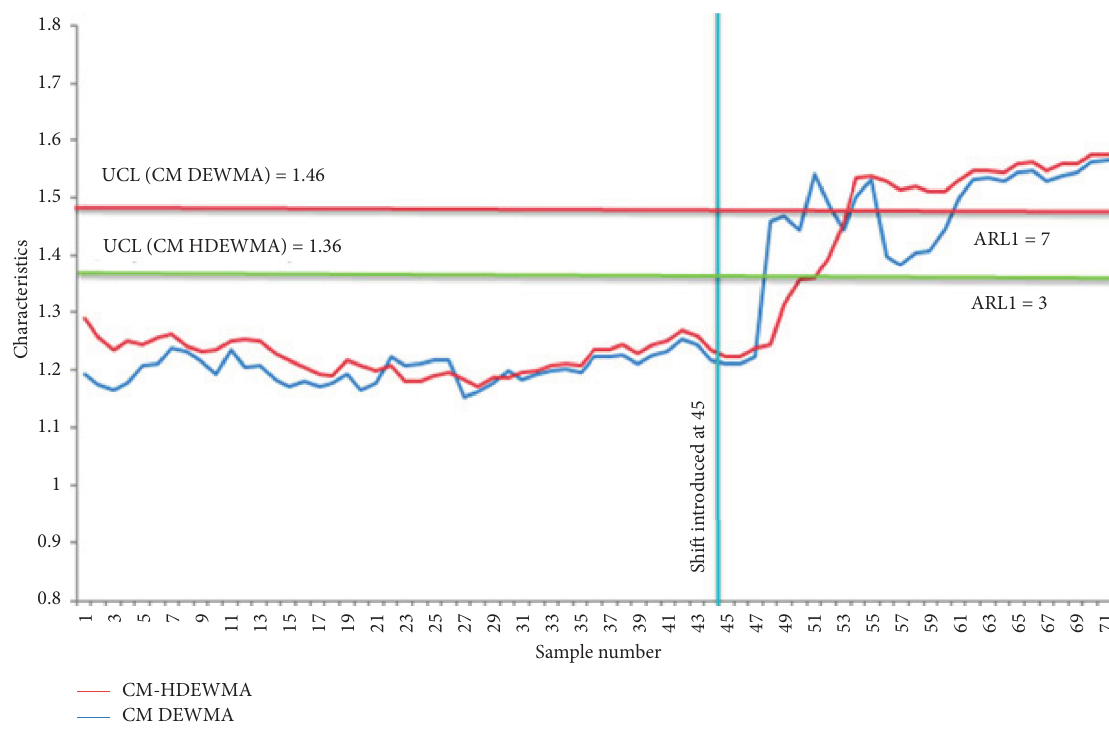
Figure 3: A comparison of CM-DEWMA and CM-HDEWMA charts using 25% decrease in the mean for the socket